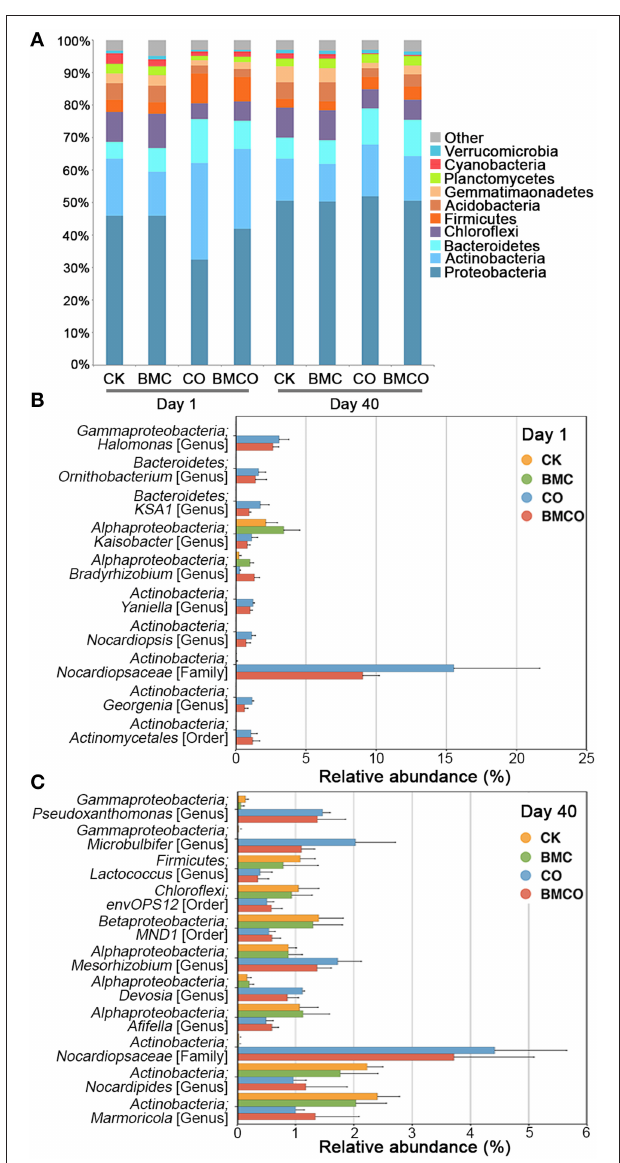
FIGURE 2 | Bacterial community compositions. (A) The distribution of the 10 most abundant phyla across treatments in day 1 and day 40. (B) The average relative abundance of 10 most abundant OTUs that significantly differed in comparison of treatments with and without compost (CK and BMC vs. CO and BMCO) in day 1, n = 5. (C) The average relative abundance of 10 most abundant OTUs that significantly differed in comparison of treatments with and without compost (CK and BMC vs. CO and BMCO) in day 40, n = 5. P < 0.05 with adjustment of Benjamini–Hochberg for multiple